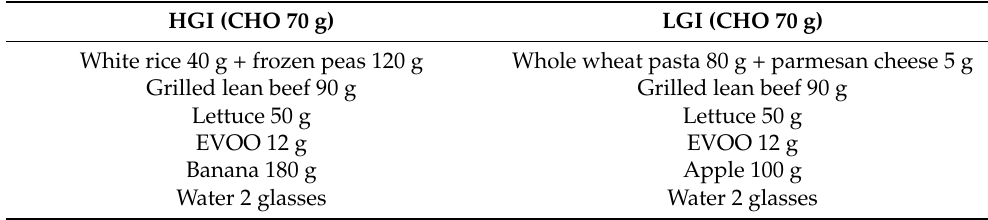
Table 2. Composition of the two test meals.